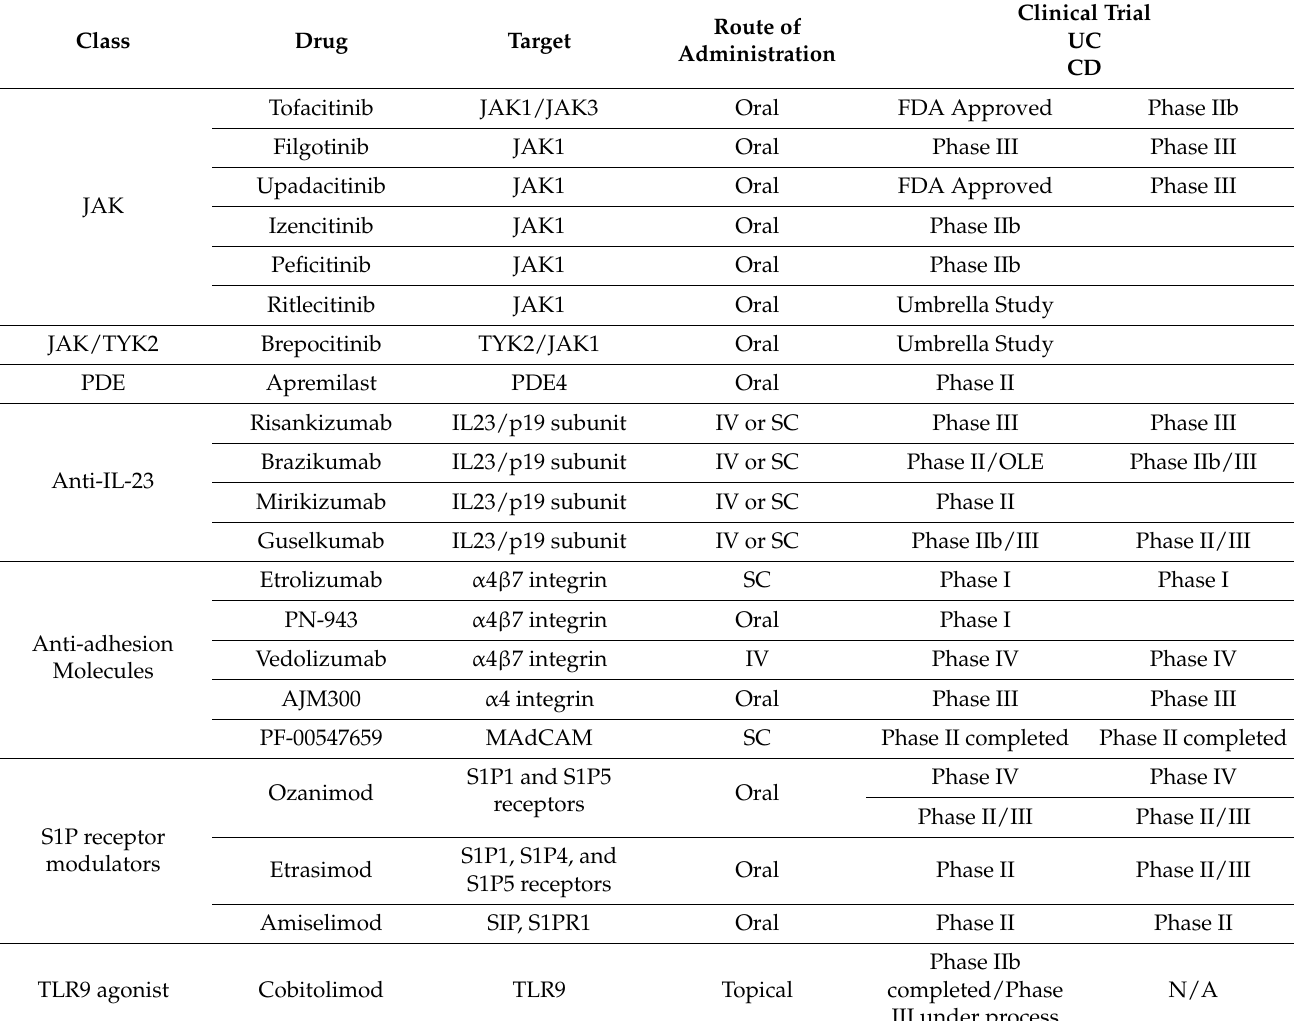
Table 1. Small molecules and biologics with their targets, modes of administration, and clinical trial